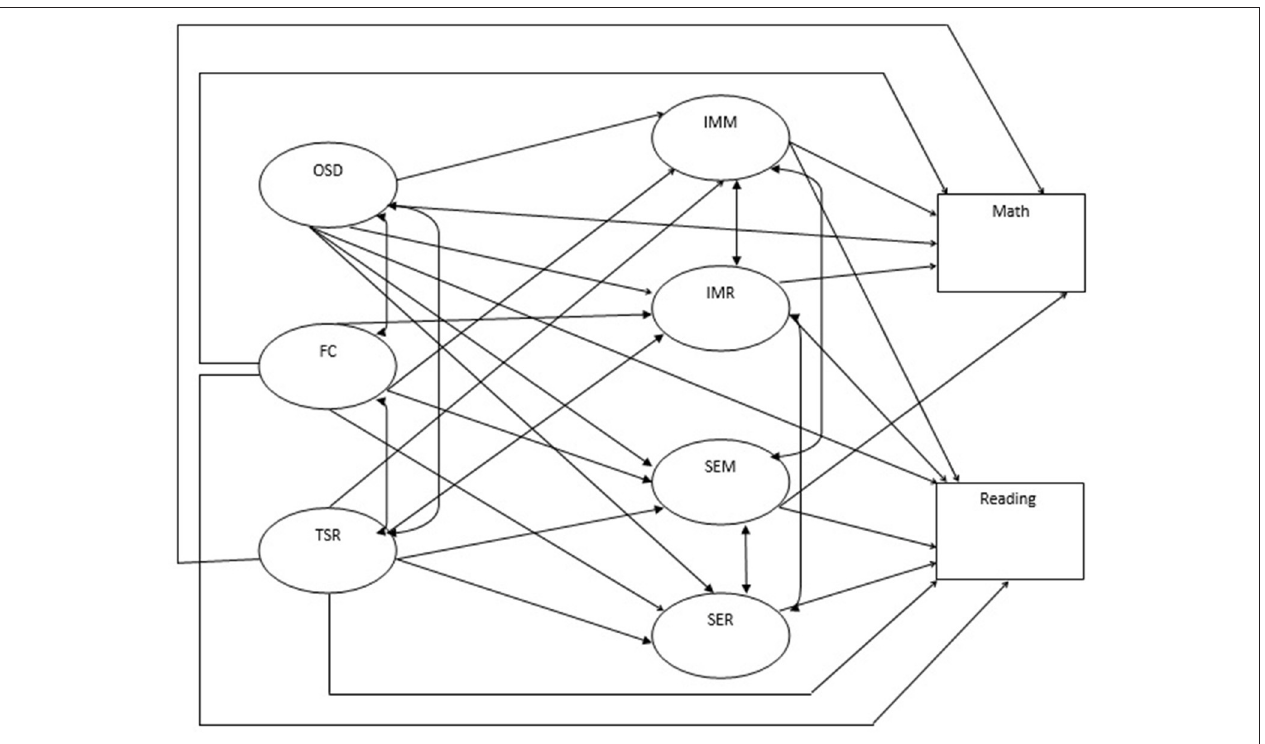
FIGURE 1 | Model illustrating the hypothesized relations between perceptions of school climate, student motivation, and academic achievement. OSD, Order/Safety/Discipline; FC, Fairness/Clarity of Rules; TSR, Teacher/Student Relationship; IMM, Intrinsic Motivation Math; IMR, Intrinsic Motivation Reading; SEM, Self-Efficacy Math; SER, Self-Efficacy